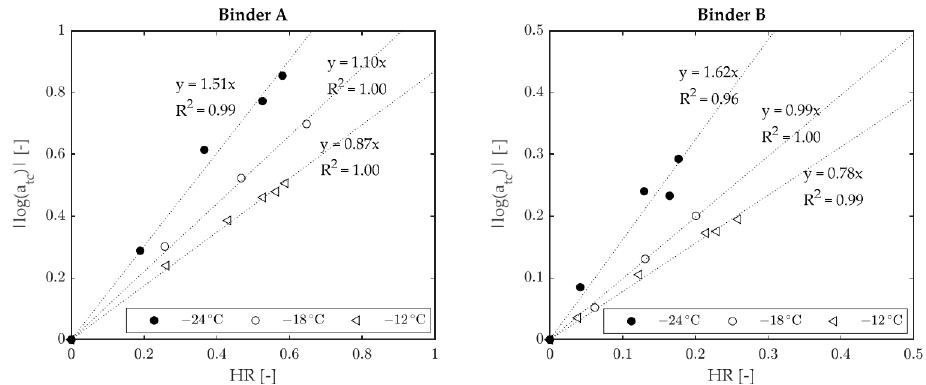
Figure 7. Relationship between horizontal shift factors and HR.